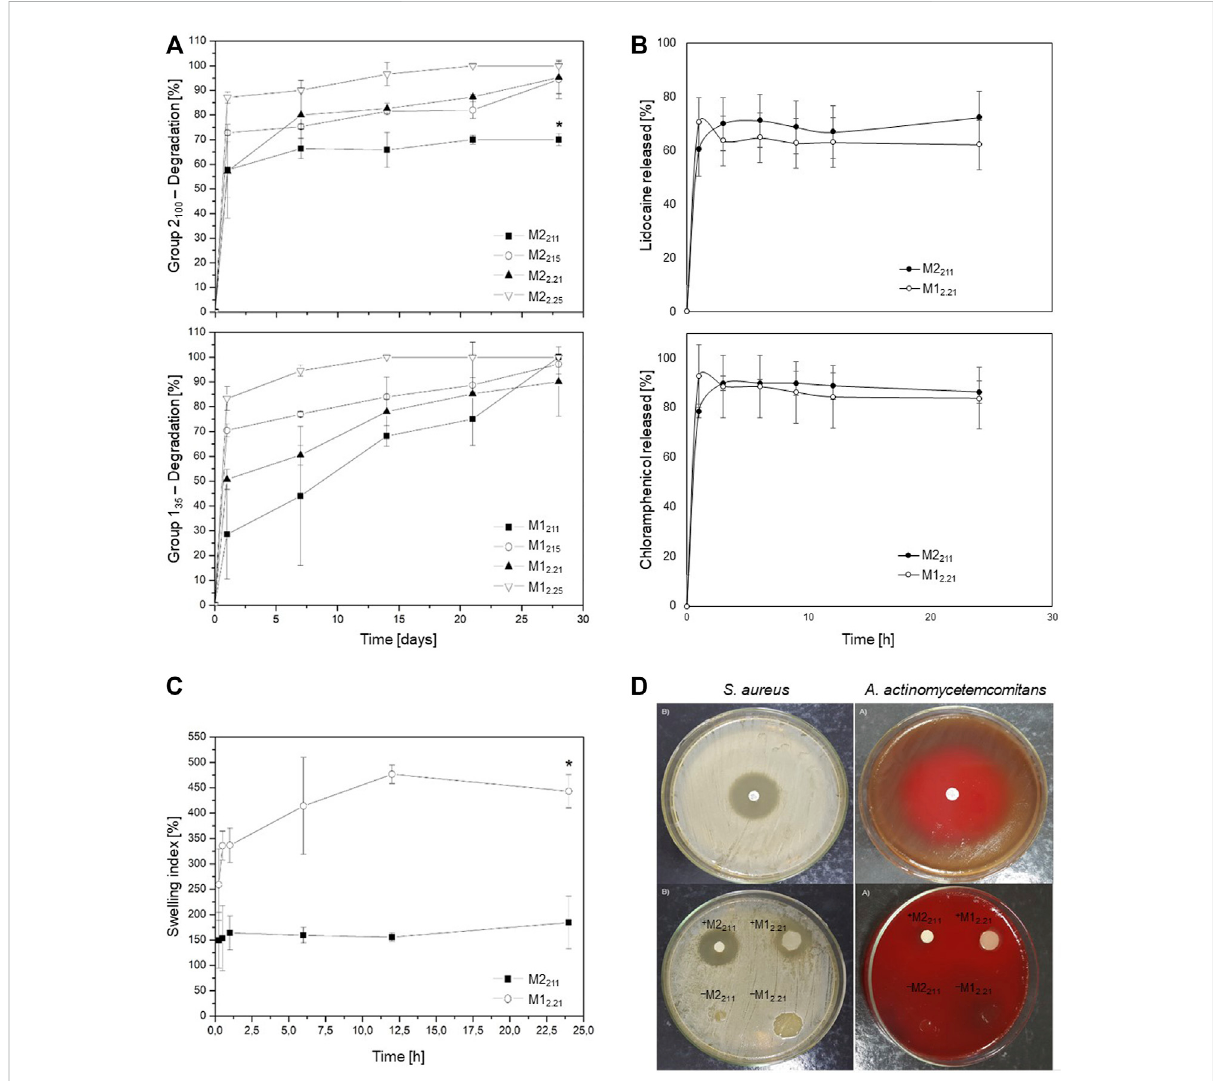
FIGURE 3 Biomembranes degradation, swelling, release kinetics, and antibacterial activity. (A) Degradation pro fi les of membranes incubated in simulated saliva. (B) Swellingpro fi lesofmembranesM1 2.21 andM2 211 insimulatedsaliva. (C) LDNPandCHNPreleasepro fi lesfrommembranesM1 2.21 andM2 211 . (D) Chloramphenicol (top), M1 2.21 and M2 211 (bottom) antibiotic activity against S. aureus and A. actinomycetemcomitans . The superscripts + and − indicate whether M1 2.21 and M2 211 were embedded or not with LDNP and